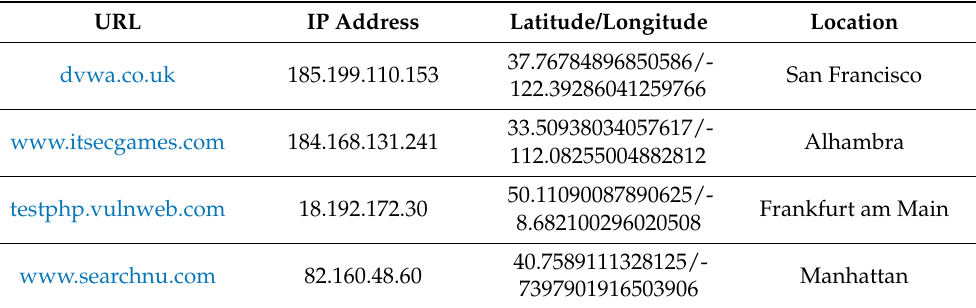
Table 1. IP address, latitude, longitude, location of the main server of provided URL. URL IP